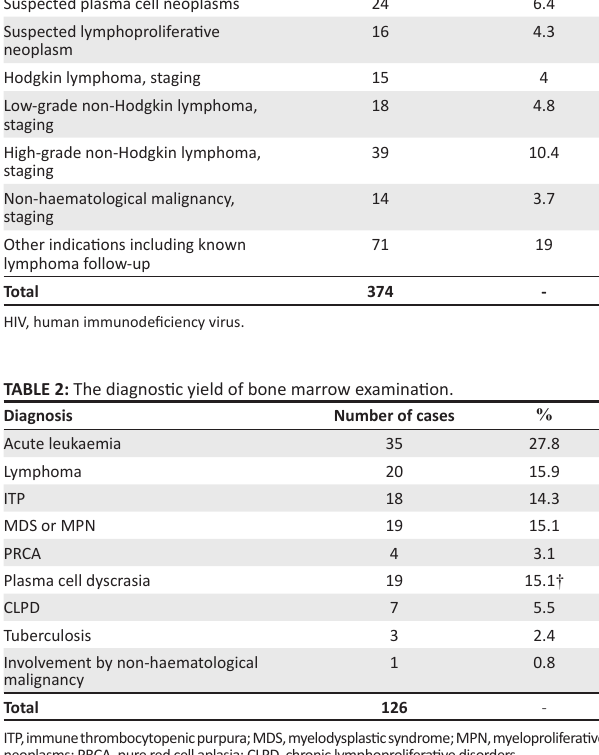
FIGURE 1: Detailed breakdown of the category ‘other indications’.